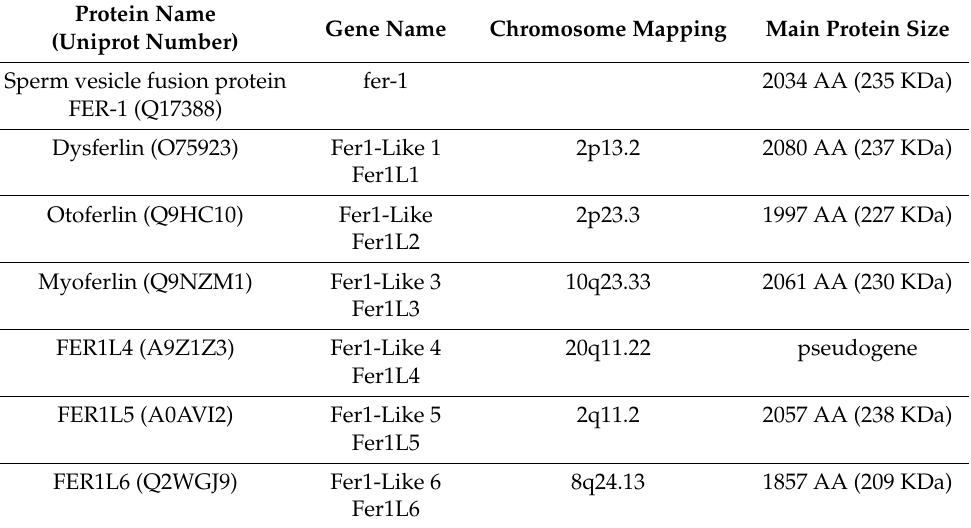
Table 1. Short description of C. elegans and human ferlin genes and